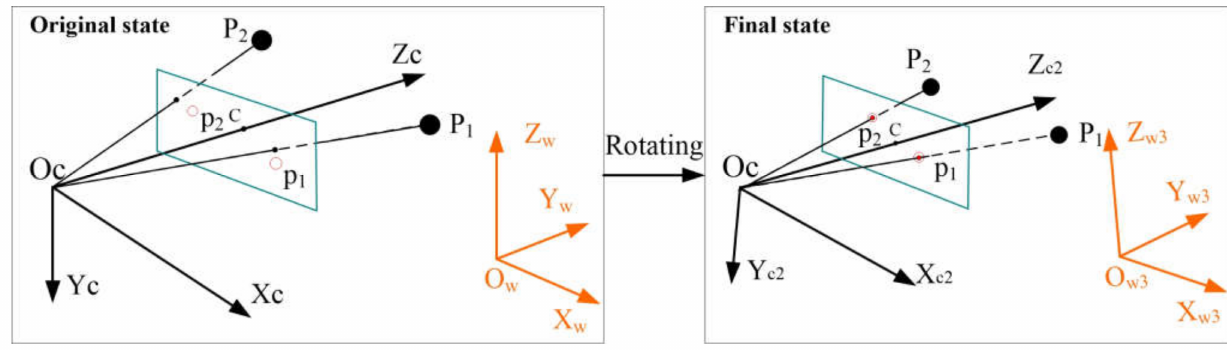
Figure 3. Rotating for pose